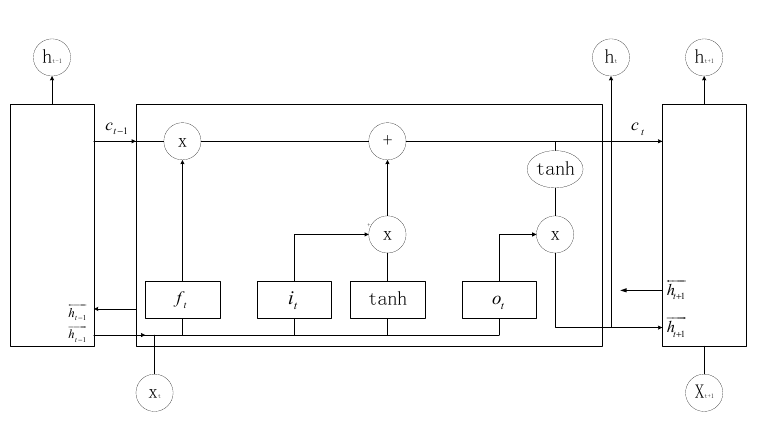
Figure 5. Schematic diagram of BiLSTM structure.